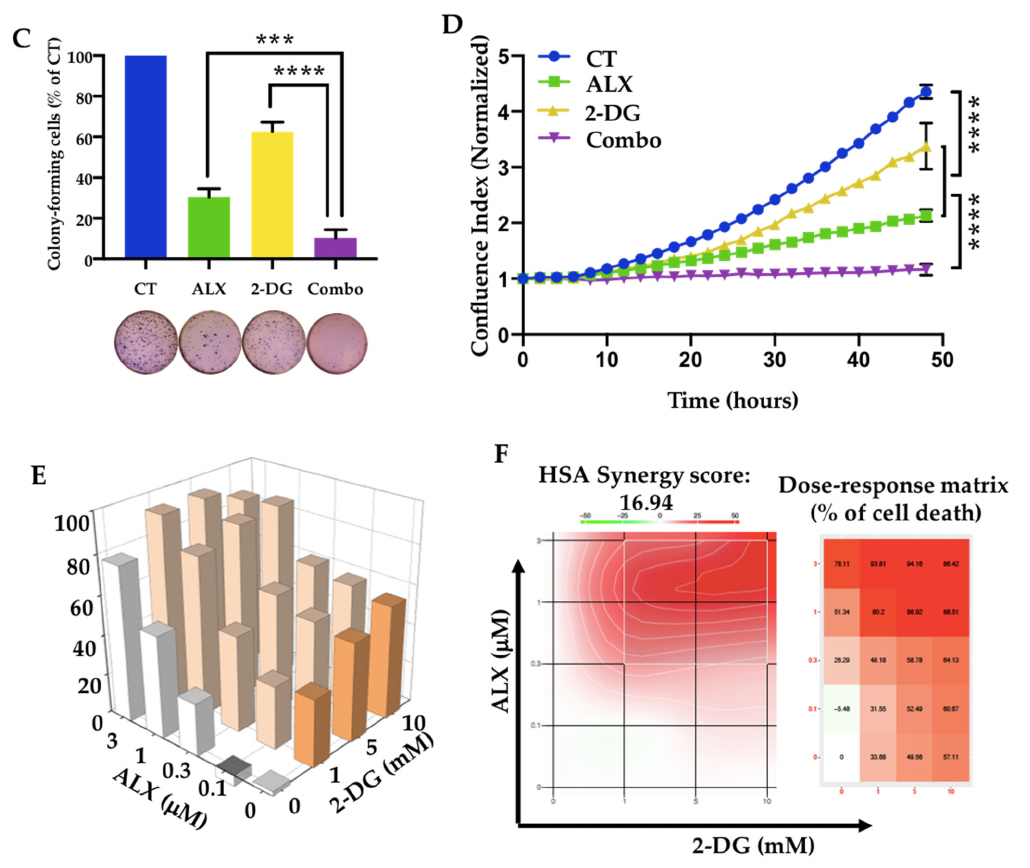
Figure 4. Alexidine inhibited the mitochondrial respiratory chain, leading to leukemic cell death: ( A ) K562 cells were pretreated either with 1 µ M alexidine (ALX) or 1 µ M imatinib (IM), or left untreated (NT), for 6 h and 18 h, respectively. Oxygen consumption rate (OCR) was evaluated with a Seahorse XF96 Extracellular Flux Analyzer with the Mito Stress test after injection with 1 µ M oligomycin (O), 0.5 µ M FCCP, and 1 µ M concentrations of both rotenone (R) and antimycin A (A). Data are expressed as mean ± SD, representative of 3 independent experiments performed in quadruplicate. Quantification of basal respiration, maximal respiration, and ATP-coupled OCR production (ATP/OCR) is shown in the indicated histograms. Data are expressed as the mean ± SD, representative of 3 independent experiments performed in quadruplicate. ** p < 0.01, **** p < 0.0001 one-way ANOVA analysis. ( B ) K562 cells were stimulated or not with 1 µ M alexidine (ALX) for 24 h. Cell lysates were analyzed by immunoblotting for the indicated proteins. ( C ) Clonogenic analysis of K562 cells treated for 7 days with vehicle (CT), 1 µ M alexidine (ALX), 10 mM 2-deoxyglucose (2-DG), or their combination (Combo); *** p < 0.001, **** p < 0.0001, one-way ANOVA. ( D ) Proliferation curves of K562 cells treated with DMSO (CT), 1 µ M alexidine (ALX), 1 µ M imatinib (IM), 10 mM 2-deoxyglucose (2-DG), or combination (Combo) for 48 h. Time-lapse analysis of phase-contrast K562 cells using the IncuCyte system. Graphs show the quantification of cell numbers from phase-contrast confluence counting. Data are the mean ± SD (n = 3); **** p < 0.0001, 2-way ANOVA. A.U. = arbitrary unit. ( E ) Cell death 3D graphs of K562 cells treated with the indicated doses of alexidine (ALX) and 2-deoxyglucose (2-DG) after DAPI staining. Cell death is expressed as the percentage of control. ( F ) Synergy density plots displaying the distribution of synergy and the dose–response matrix of K562 cells after ALX/2-DG treatments. Combination scores are represented from green (antagonism) to red (strong synergy), following a color gradient. On the dose–response matrix, % of cell death is represented following a color gradient from low to high cell